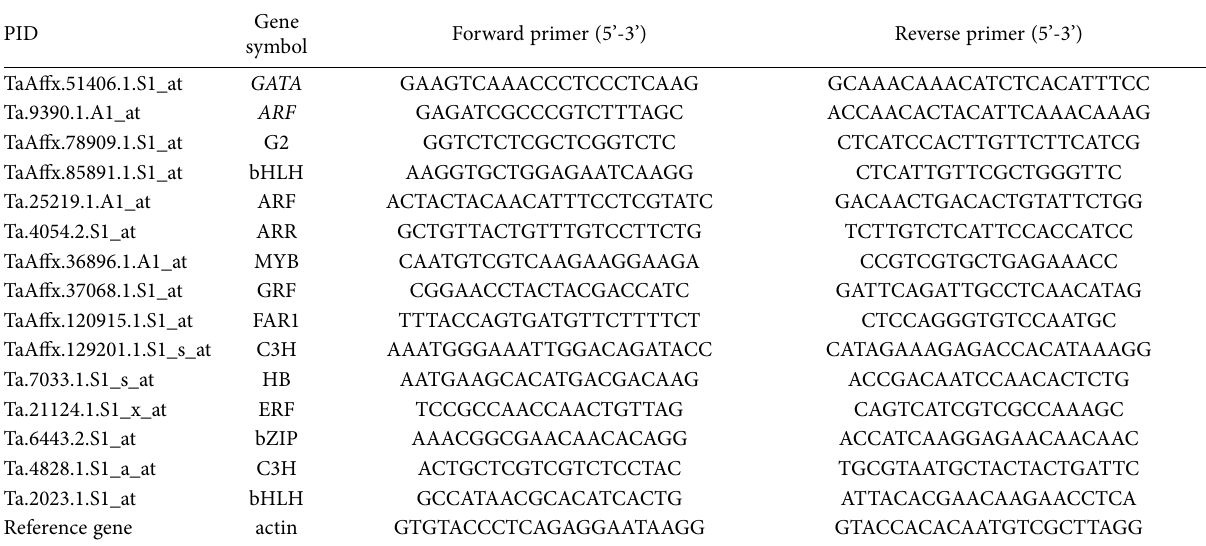
Table 1. List of primer pairs using for validation of gene expression using qRT-PCR. PID